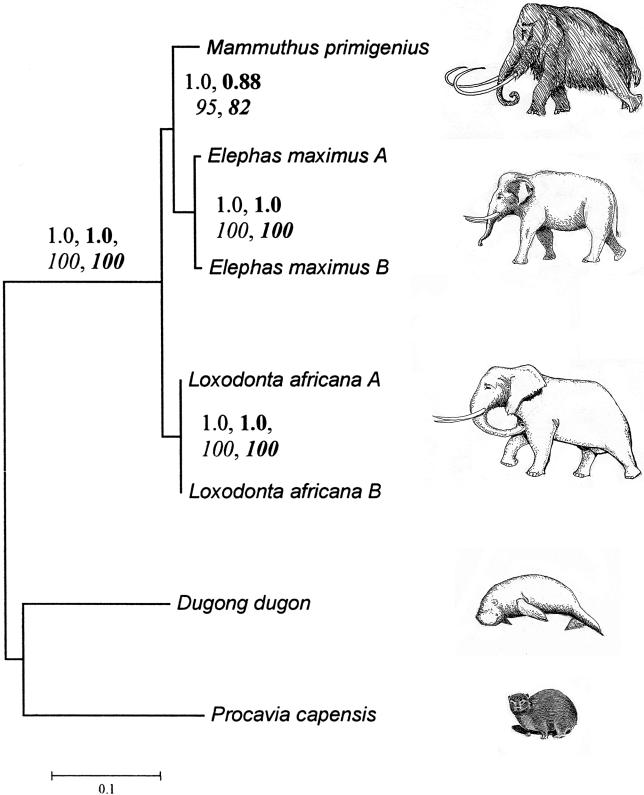
Paenungulata Tree and Phylogenic Relationship of the Woolly MammothThe analysis of complete mtDNA sequences placesM. primigenius withE. maximus on the tree. The Sirenia(D. dugon) and Hyracoidea(P. capensis), most closely related species among extant taxa to Elephantinae, were taken as outgroups. Bootstrap values and posterior probabilities were calculated using a Bayesian approach [29,31] assuming a gamma distribution of the rates of evolution across sites with a General Time Reversible model (normal font), HKY model (bold), with a parsimony approach (italic), and by neighbor joining (italic and bold) [28]. The scale is 0.1 substitutions per site. The mitochondrial genomes ofM. primigenius, E. maximus A, E. maximus B, L. africana A, L. africana B, D. dugon, andP. capensis were used in the analysis.